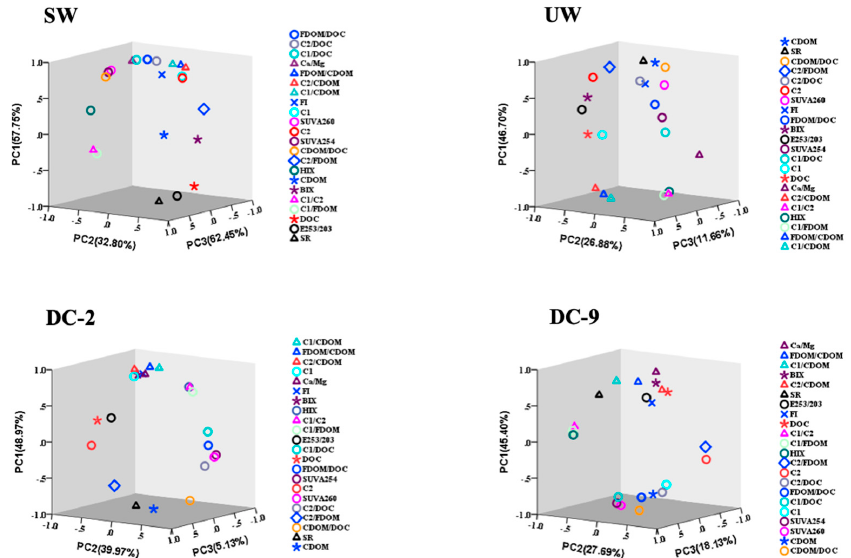
Figure 7. PC1, PC2, and PC3 loadings of optical indices and the relationship between organic components percentages and structures of DOM in surface (SW) and underlying (UW) water as well as pore water in sediments of DC-2 and DC-9. PC1, PC2, and PC3 were obtained from principal component analysis. PC1: first primary component; PC2: second primary component; PC3: third primary component.